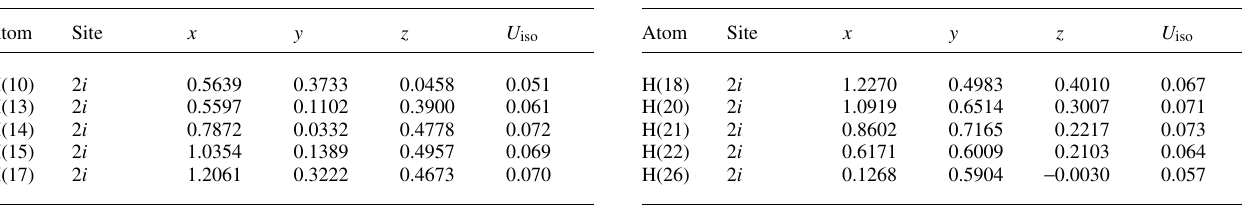
Table 3. Atomic coordinates and displacement parameters (in Å 2 )